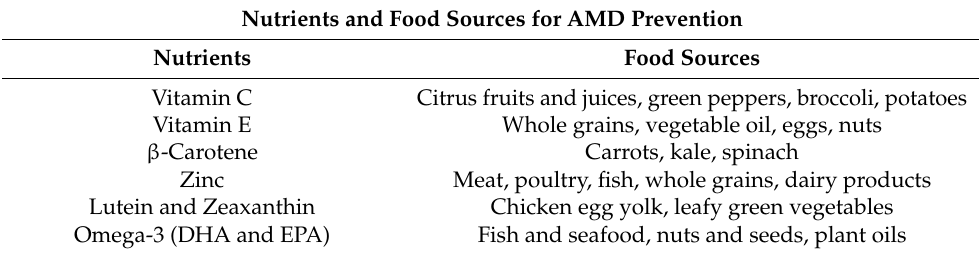
Table 2. Nutrients and their food sources capable of preventing the onset of